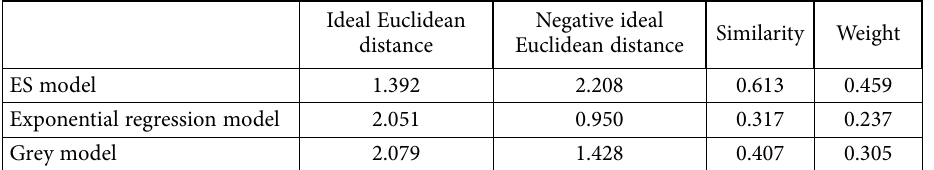
Step 7: Error verification for the combined forecasting model